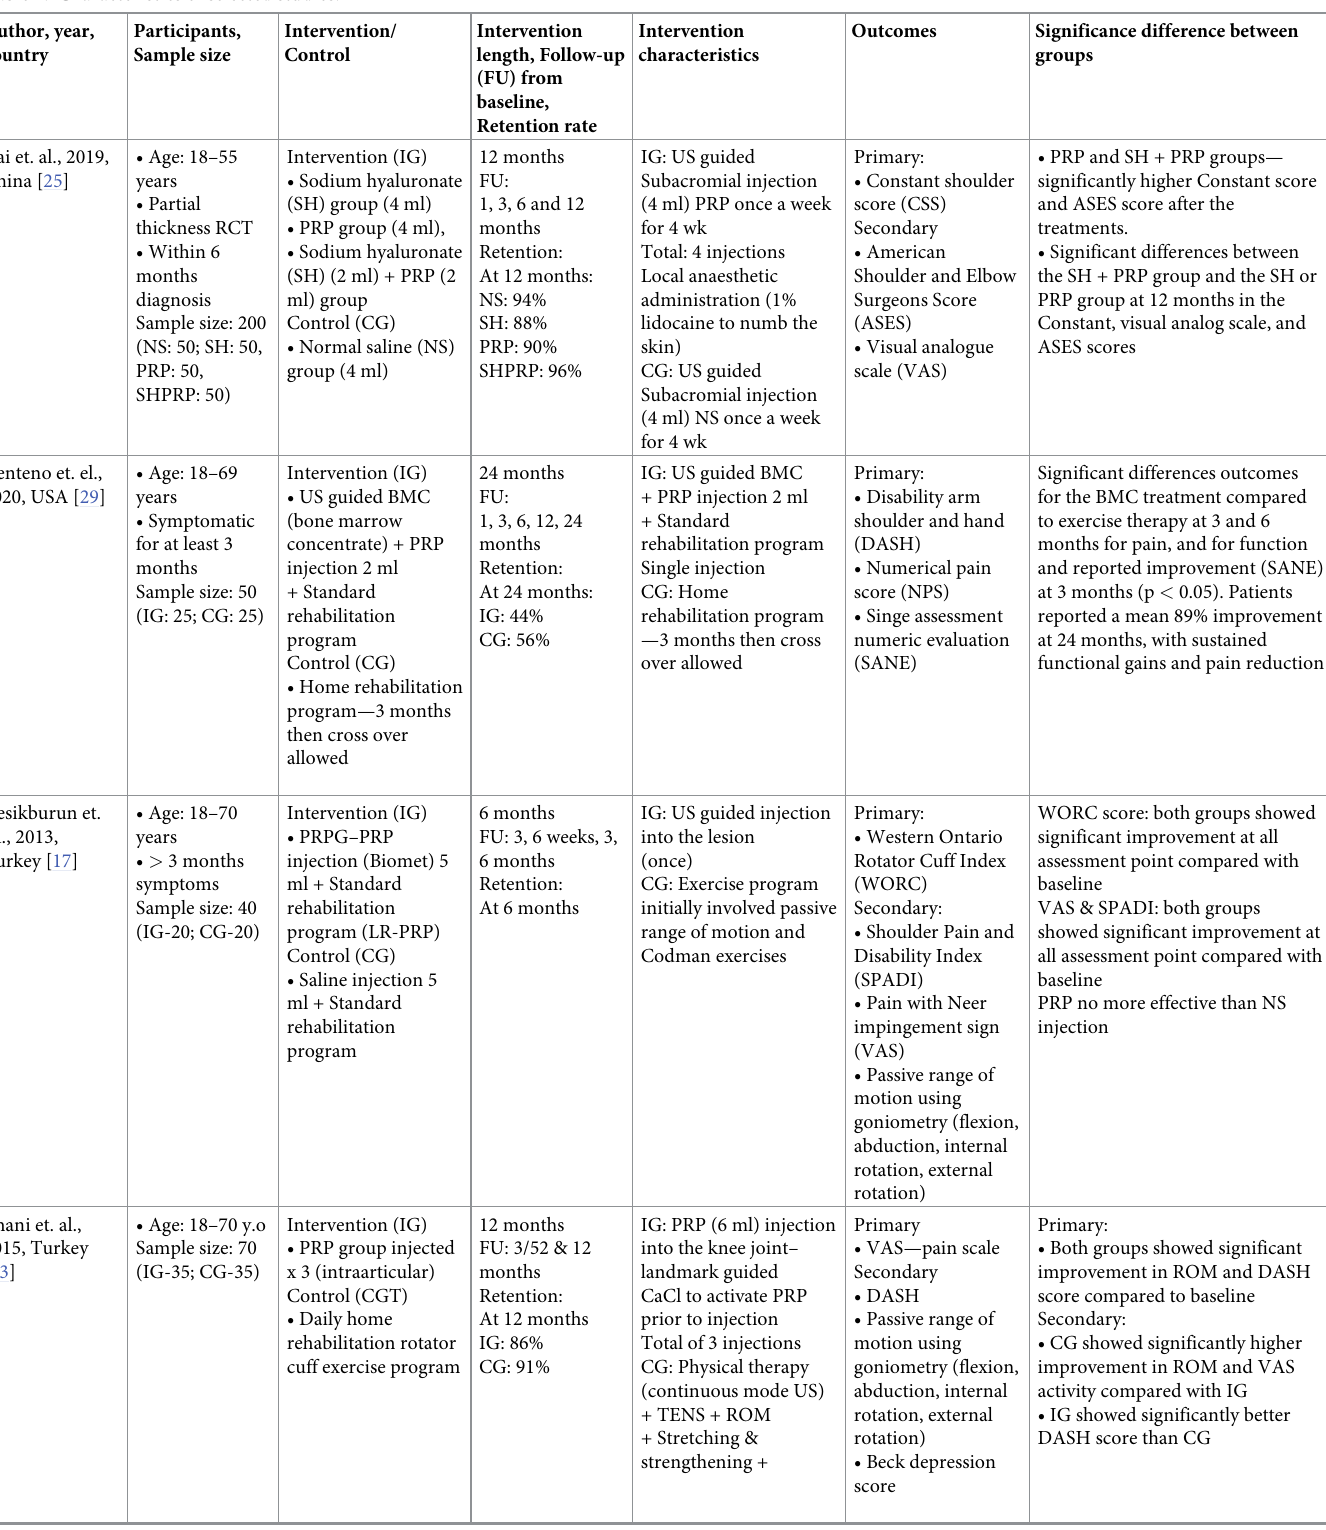
Table 1. Characteristics of selected